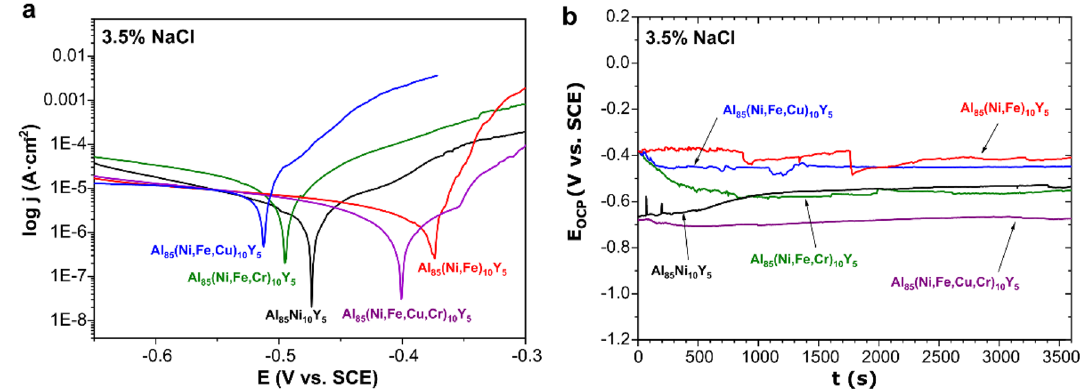
Figure 2. ( a ) Polarization curves and ( b ) Variation of the open-circuit potential with time measured for Al 85 TMs 10 Y 5 alloys in 3.5% NaCl solution at 25 The worst corrosion resistance had the Al 85 (Ni, Fe, Cu) 10 Y 5 amorphous alloy, while some of the more favorable values were determined for amorphous Al 85 (Ni, Fe) 10 Y 5 and amorphous-crystalline Al 85 (Ni, Fe, Cu, Cr) 10 Y 5 alloys. The literature data indicate that amorphous alloys are characterized by good corrosion resistance 29,30 . However, except for the structure, the chemical composition is one of the factors responsible for the material’s behavior in an electrochemical environment. According to that, the balance between structure and properties must be obtained. In the case of melt-spun ribbons, the obtained values of Al 85 (Ni, Fe, Cu, Cr) 10 Y 5 alloy with crystallites indicate that the simultaneous addition of copper and chromium improves the corrosion resistance, which was